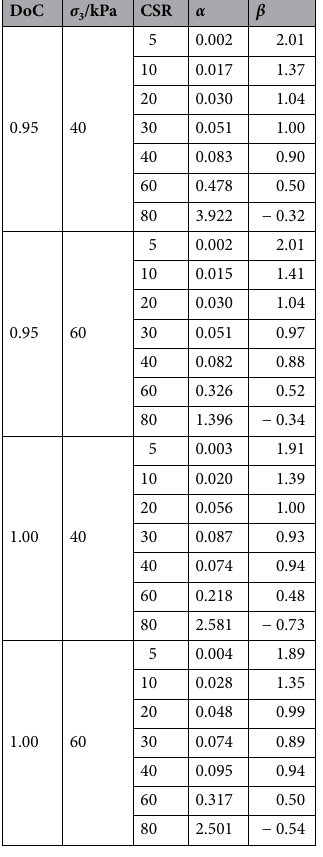
Table 3. Fitting parameters for the UGM samples under different CSRs.